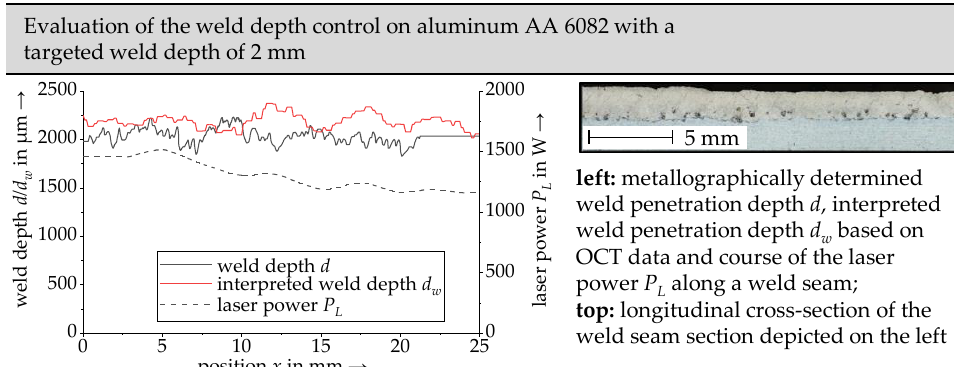
top: longitudinal cross-section of the weld seam section depicted on the left